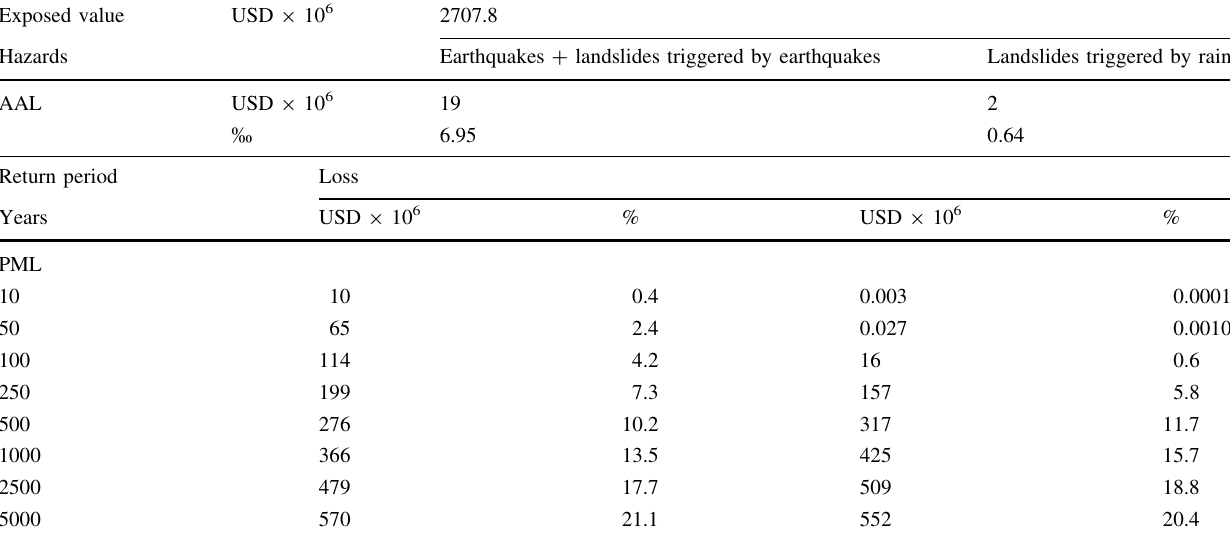
Table 1 Summary of risk results for Manizales Exposed